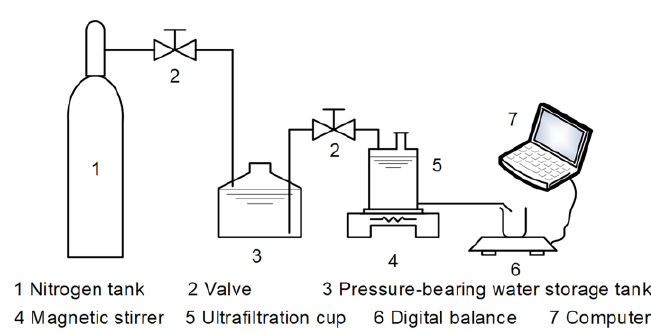
Figure 1. Schematic diagram of the experimental setup.